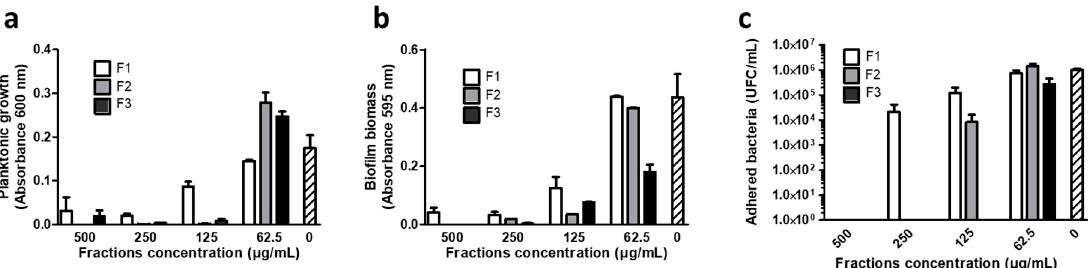
Figure 3. Antibacterial and antibiofilm activity E2-4 fractions containing dihydrowogonin as the major compound (F1, F2 and F3) against S. aureus after 24 h of contact. Hatched bars: no fraction. ( a ) Evaluation of the planktonic growth of bacteria through optical density measurement at 600 nm. ( b ) Evaluation of the total biofilm biomass through crystal violet coloration and absorbance measurement at 595 nm. ( c ) Concentration of bacteria adhered on coverslips, after ultrasonication and culture on agar plates.